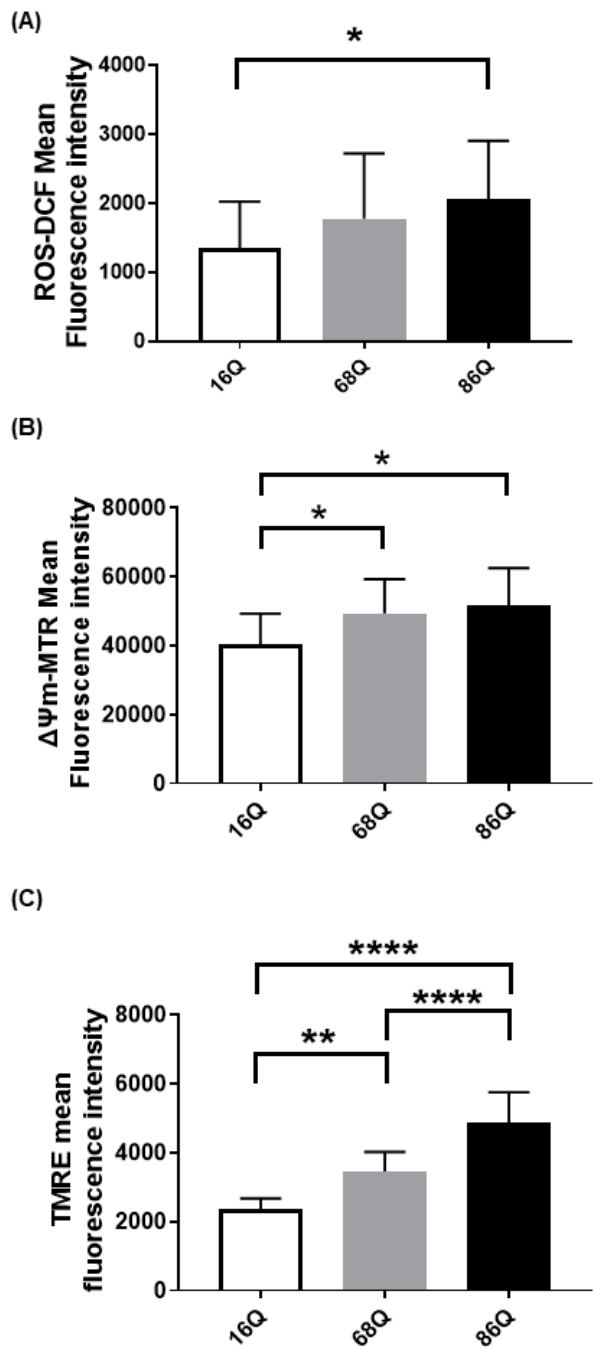
Figure 1. Elevated reactive oxygen species (ROS) production and increased mitochondrial membrane potential in HD fibroblasts. ( A ) ROS levels were determined by staining cells with 1 µ M of Carboxy-H2DCFDA for 30 min and followed by flow cytometry. Results are displayed as mean ± SD of five independent experiments and statistically significant di ff erences were calculated using ANOVA test by GraphPad Prism 8.2.1 (* p < 0.05, ** p < 0.01, *** p < 0.001). Mitochondrial membrane potentials of HD (68Q and 86Q) and control (16Q) were assessed using: Mitotracker Red CMXRos ( B ); and TMRE ( C ). Data are presented as mean values ± SD for four independent experiments. Data were analyzed using FlowJo_V10. Statistical analysis was performed using ANOVA test by GraphPad Prism 8.2.1 (* p < 0.05; ** p < 0.01, **** p < 0.0001 compared to healthy control).